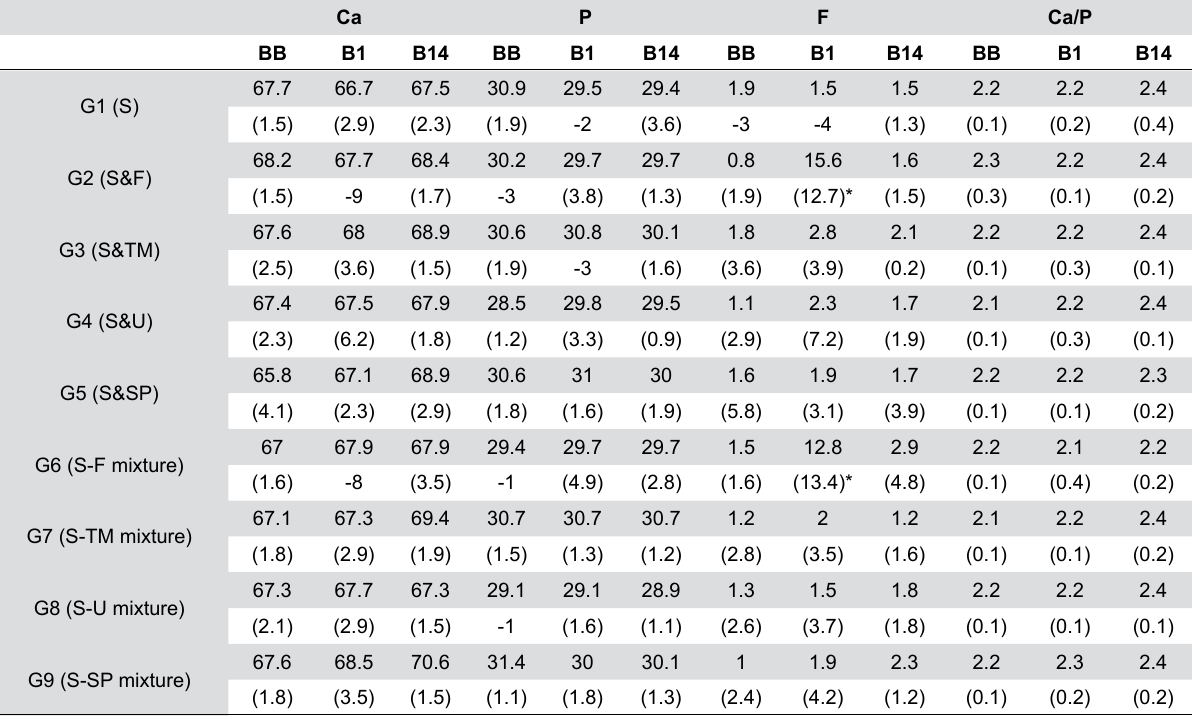
Effects of in-office bleaching agent combined with different desensitizing agents on